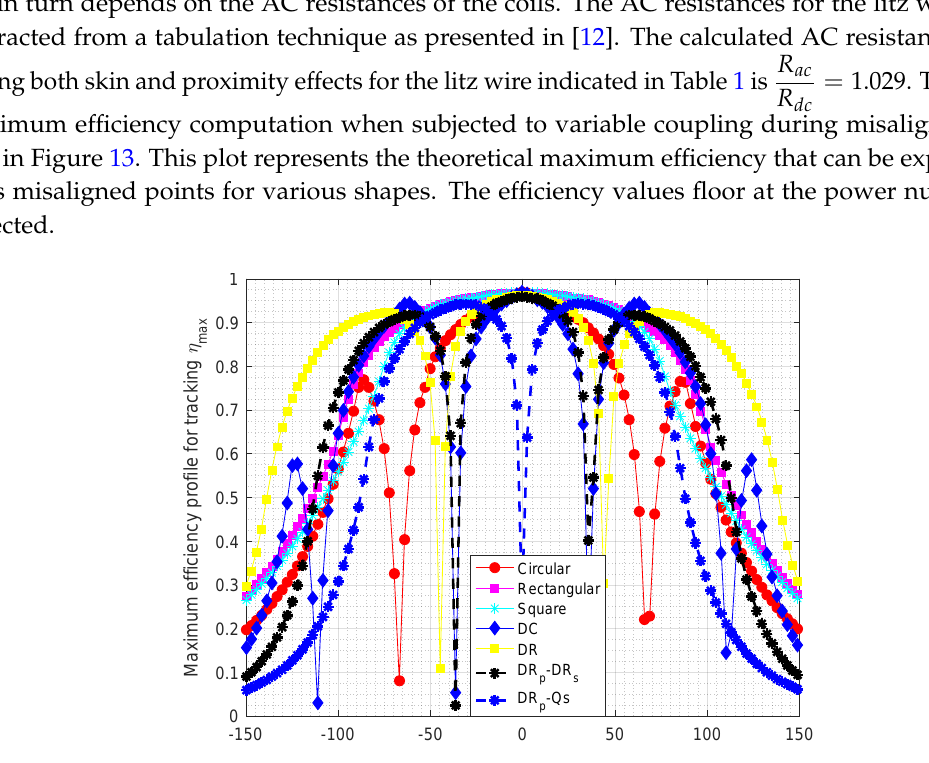
Figure 13. Maximum efficiency profile tracking with x-directional misalignment of coils in Table